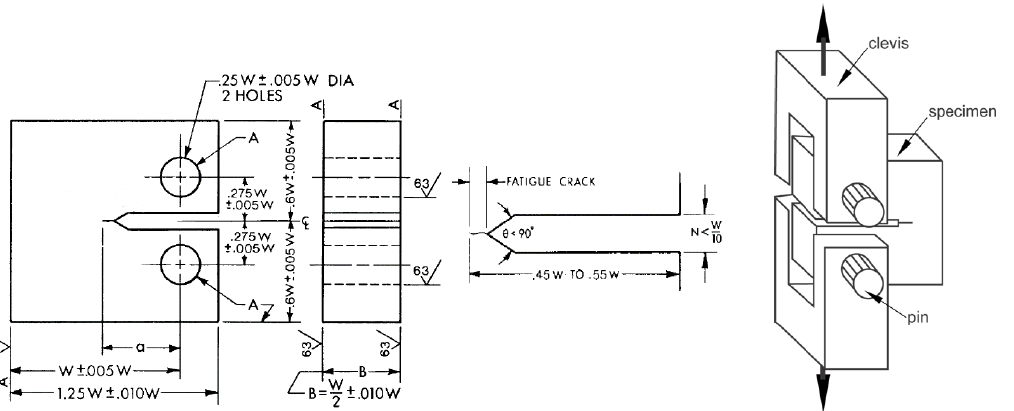
Figure 1: Scheme of the used CT-specimen.